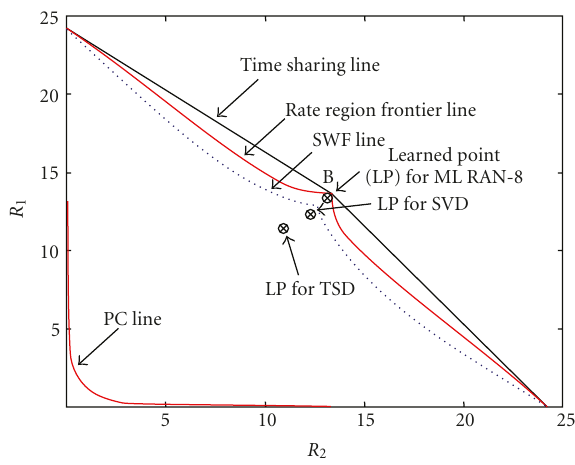
Figure 13: SVD-MIMO rate region—channel case 2.